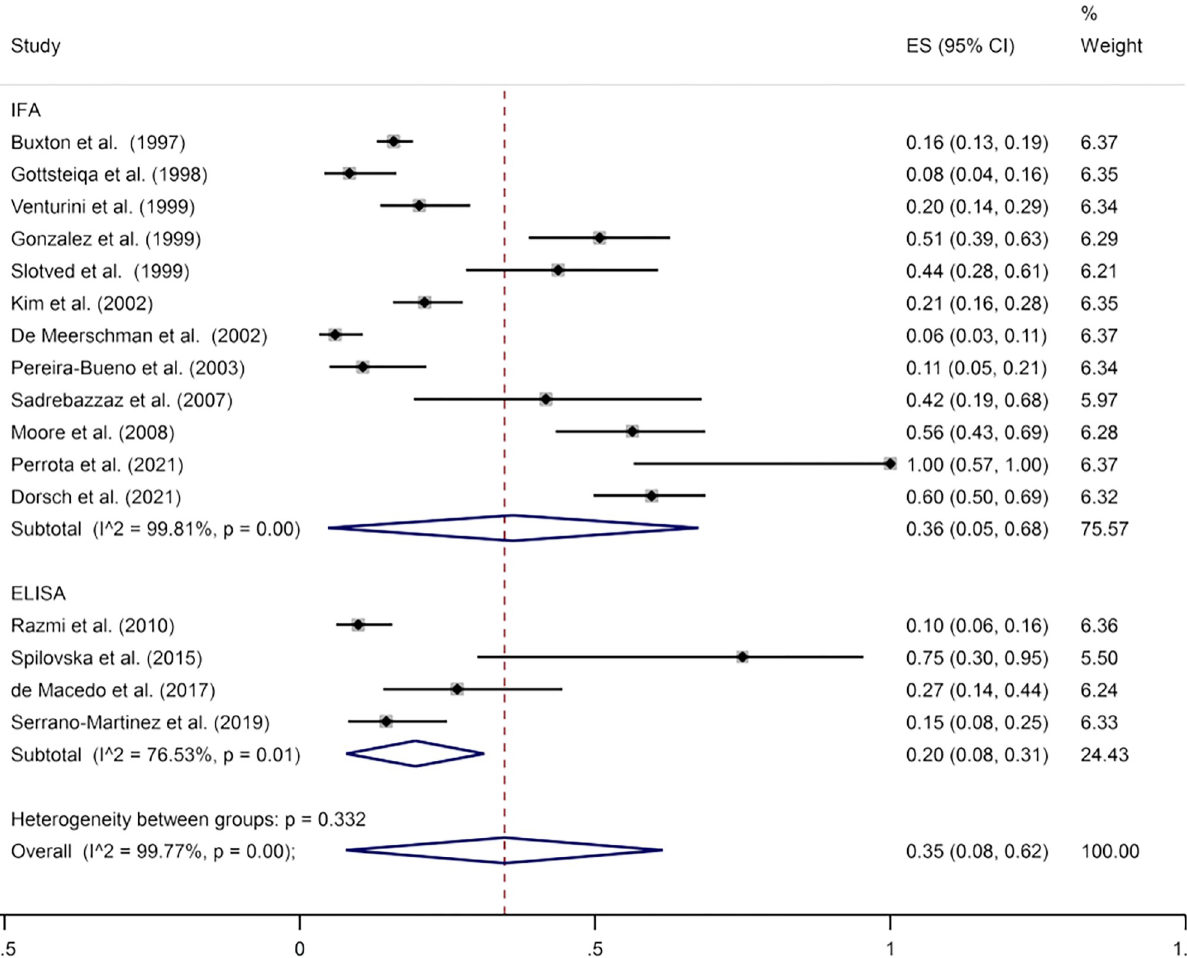
Fig 3. The pooled seroprevalence rate of anti- N . caninum antibodies in the bovine aborted fetuses.